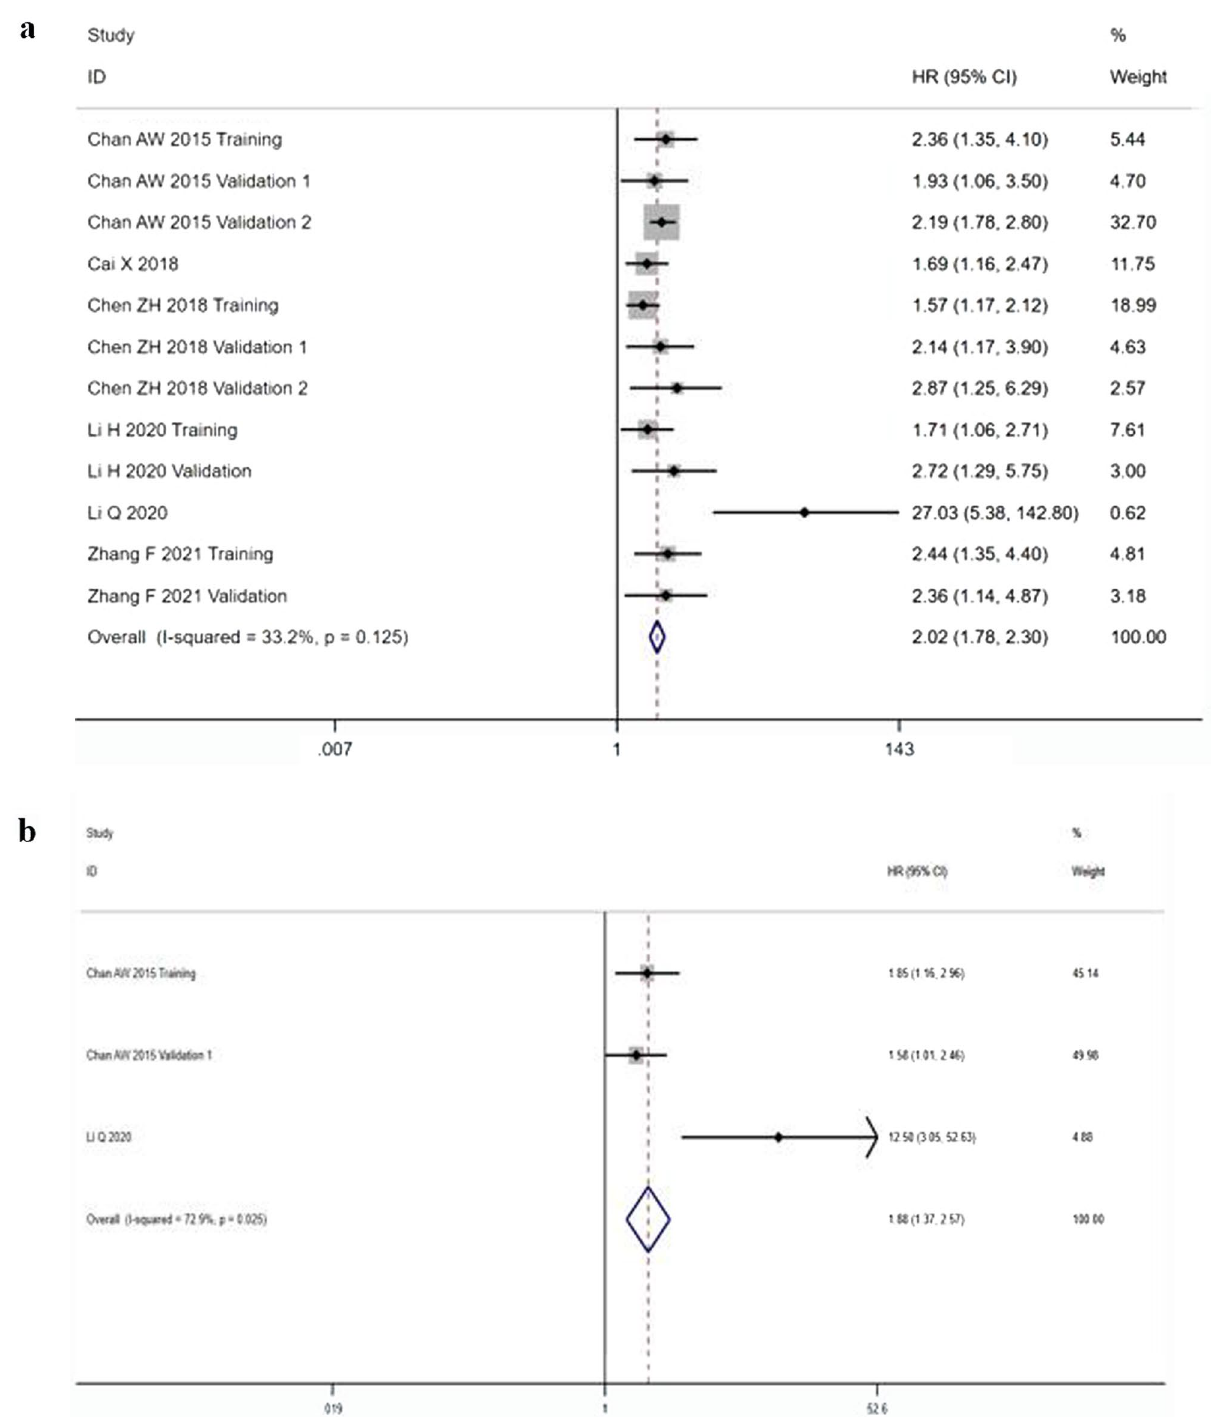
Figure 2. Forest plots of HR for OS ( a ) and RFS by multivariate analytic results ( b ) in patients with